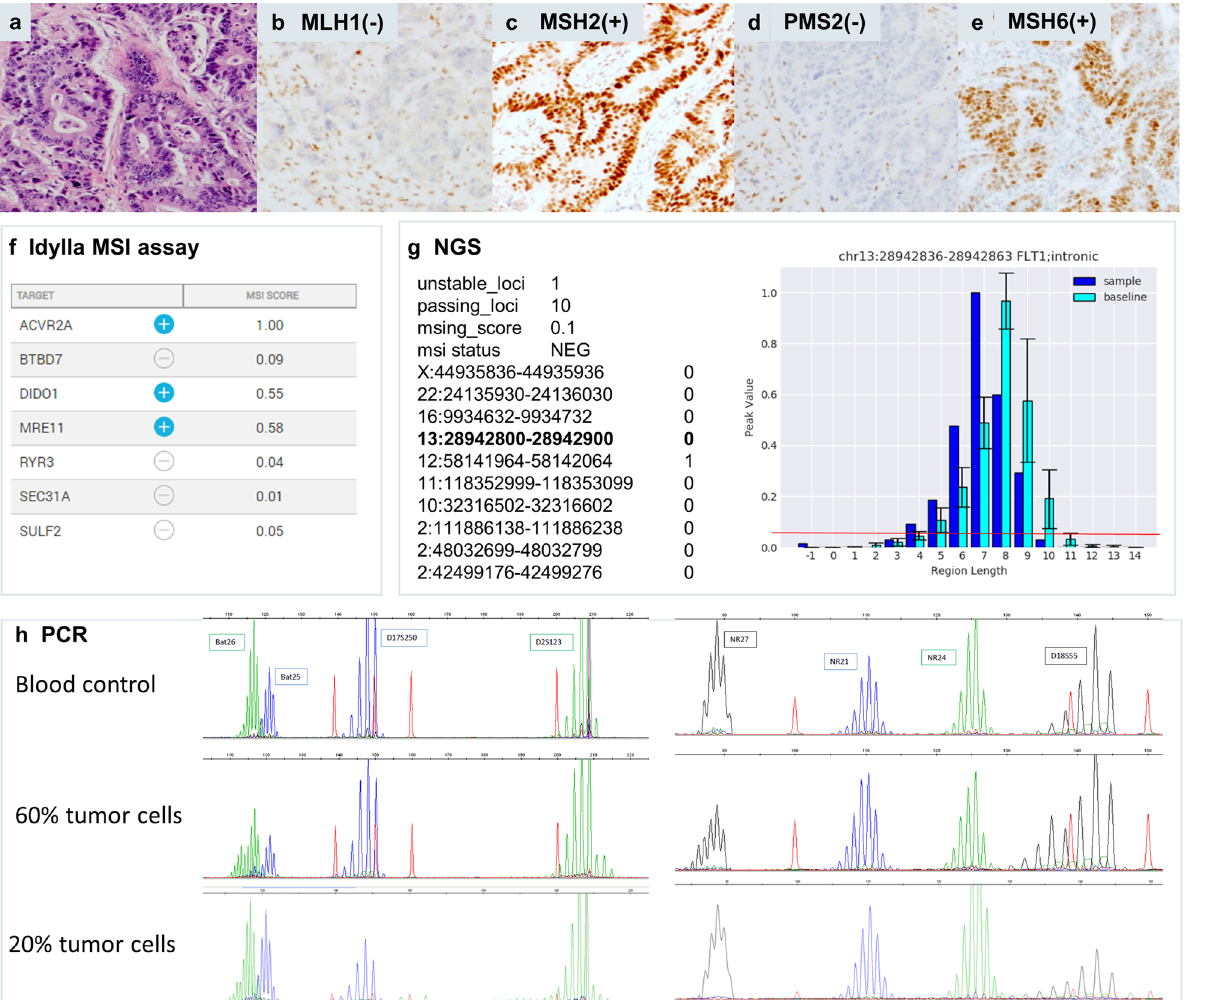
Figure 5. Colorectal dMMR/MSI tumor (case 4) with concordant results between IHC and Idylla MSI assay but falsely negative by PCR and NGS due to low tumor cell percentage. Hematoxylin eosin stain ( a ) of the tumor with classic morphology of colorectal adenocarcinoma with combined nuclear loss of expression of MLH1 ( b ) and PMS2 ( d ) and preserved nuclear staining for MSH2 ( c ) and MSH6 ( e ). A sample with 20% tumor cells was extracted and analyzed by the three molecular methods. Idylla MSI assay ( f ) indicated 3/7 loci MSI resulting in an integrative MSI-high score (Idylla Explore software v.2.5.1294). By NGS ( g ) only 1 of 10 loci was called unstable (Python v.3.7 and Matplotlib 3.3.4 software), resulting in an integrative falsely negative MSS result. Illustrative indel distribution plot of the FLT1 locus: both in the tumor (dark bue bar) and in baseline (light blue bars) 6 indel peaks were integrated above the threshold (red line, > 0.05 peak value or 5% of total reads for this locus). A clear shift towards shorter indel lenghts was visible in the indel distribution of the tumor sample but this did not result in a higher number of integrated peaks versus baseline, leading to calling as MSS/0. The PCR (h) on the 20% tumor cell sample was also falsely negative (GeneMapper v. 4.0 analysis software, Applied Biosystems). Repeat analysis of case 4 in a biopsy with 60% tumor cells did result in true positive MSI calling, with widening of indel distribution as compared to normal tissue (blood sample) of this same patient, panel h right